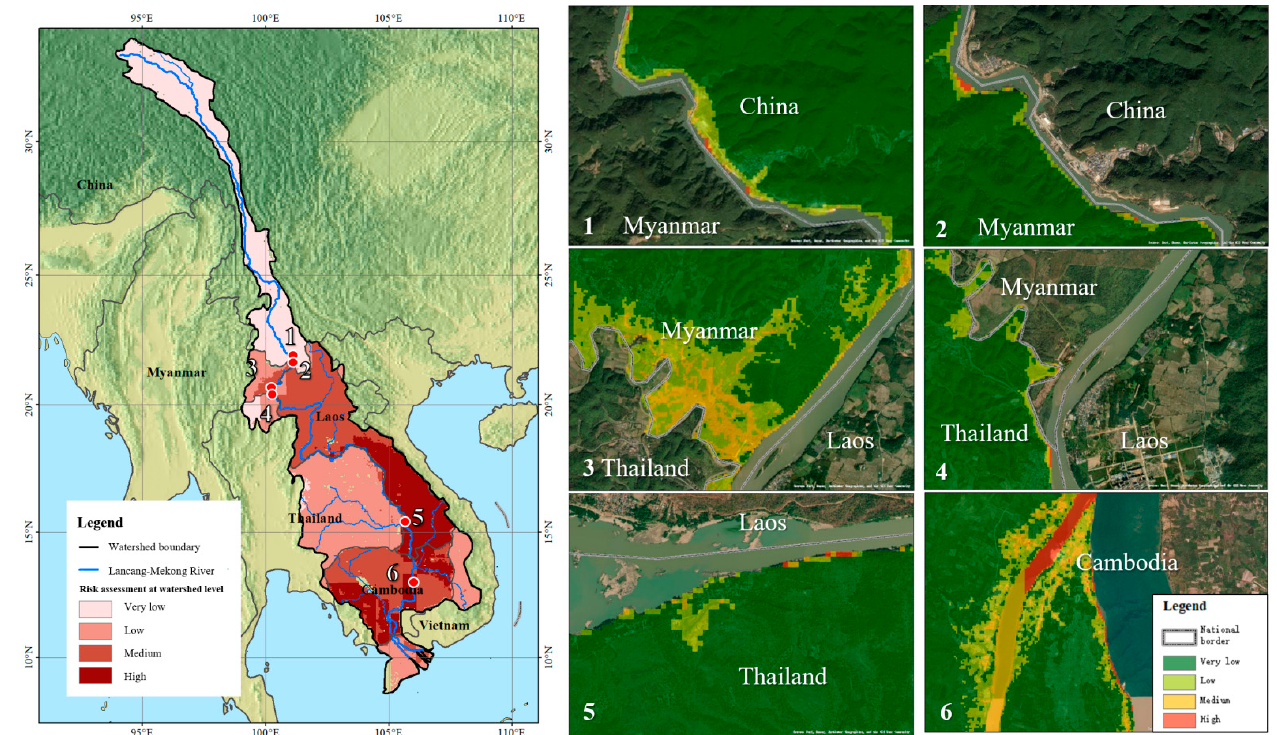
Figure 5. Risk assessment results at the community scale. (1) Guan Lei, China; (2) Mong Yawng, Myanmar; (3) Mong Hpone, Myanmar; (4) Mae Ngeon, Thailand; (5) Khong Chiam, Thailand; (6) Stung Treng, Cambodia. (National border is based on the ESRI ArcGIS Online).